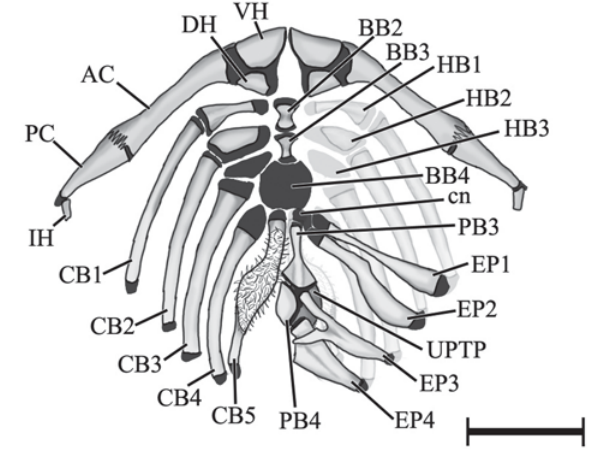
Fig. 5. Schematic illustration of the hyoid and branchial arches in dorsal view of Liosomadoras oncinus , based on MZUSP 93497, 70.7 mm SL. Left side of dorsal branchial arches omitted for ease of understanding. Urohyal and branchiostegal rays not represented. AC = anterior ceratohyal, BBn basibranchials, CBn = ceratobranchials, cn = cartilaginous nodule, DH = dorsal hypohyal, Epn = epibranchials, HBn = hypobranchials, IH = interhyal, PBn = pharyngobranchials, PC = posterior ceratohyal, UPTP = upper pharyngobranchial tooth plate, VH = ventral hypohyal. Scale bar = 5 mm.